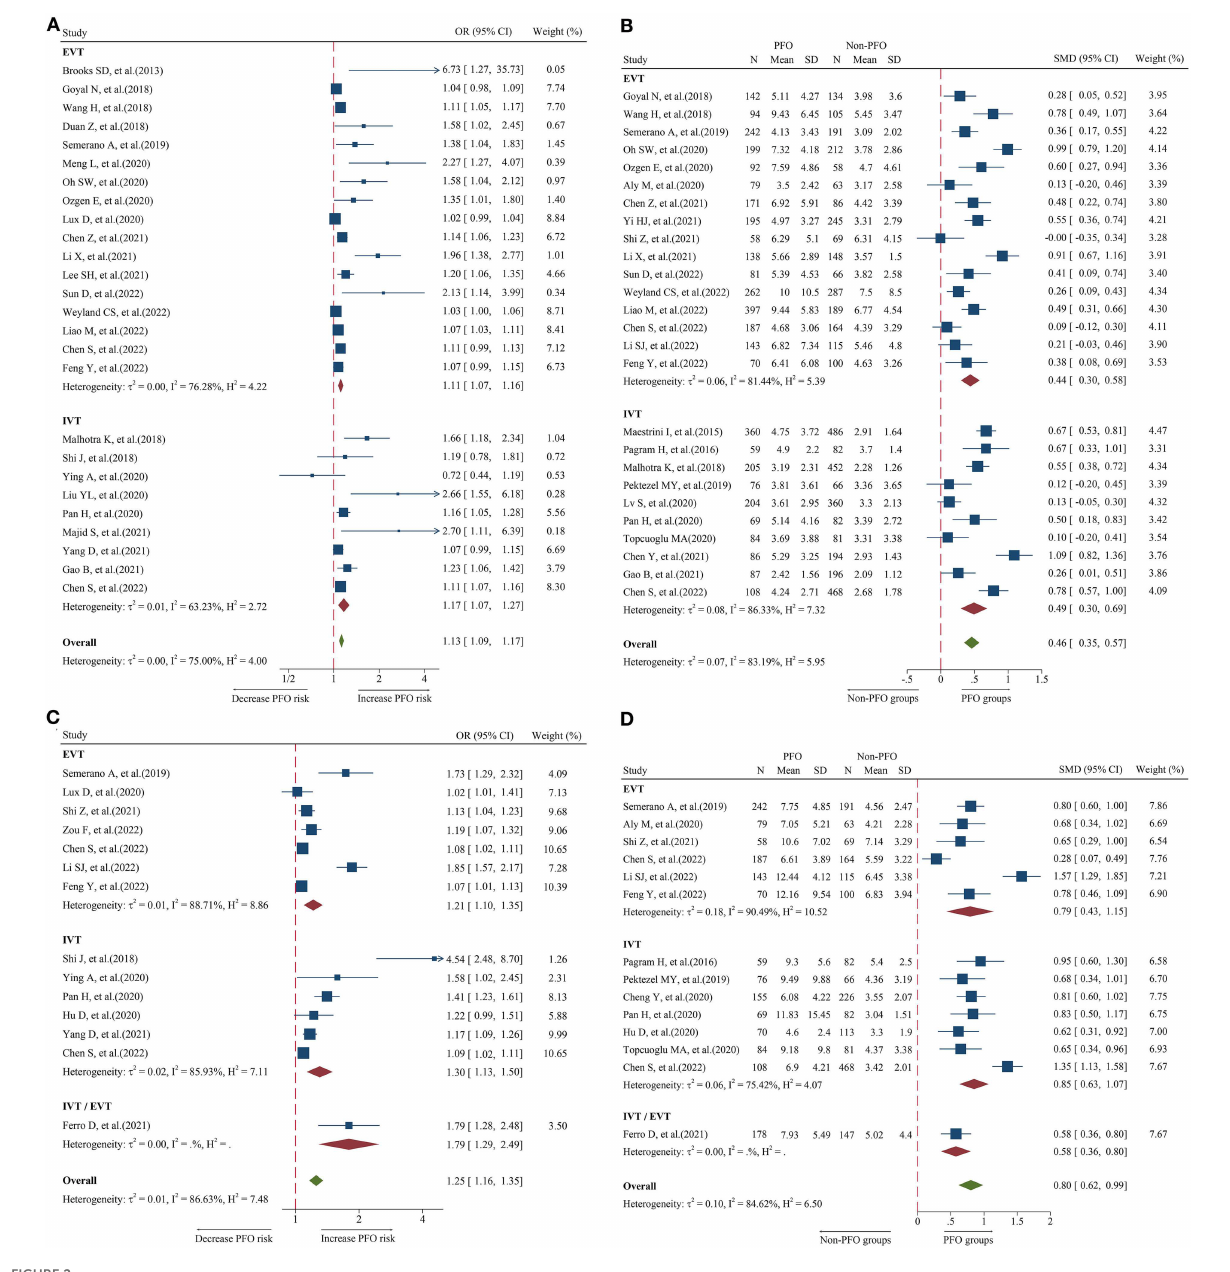
FIGURE2 Forest plot showing the association of NLR and 3-month PFO; (A) forest plot of admission NLR based on OR; (B) forest plot of admission NLR based on SMD; (C) forest plot of post-treatment NLR based on OR; and (D) forest plot of post-treatment NLR based on